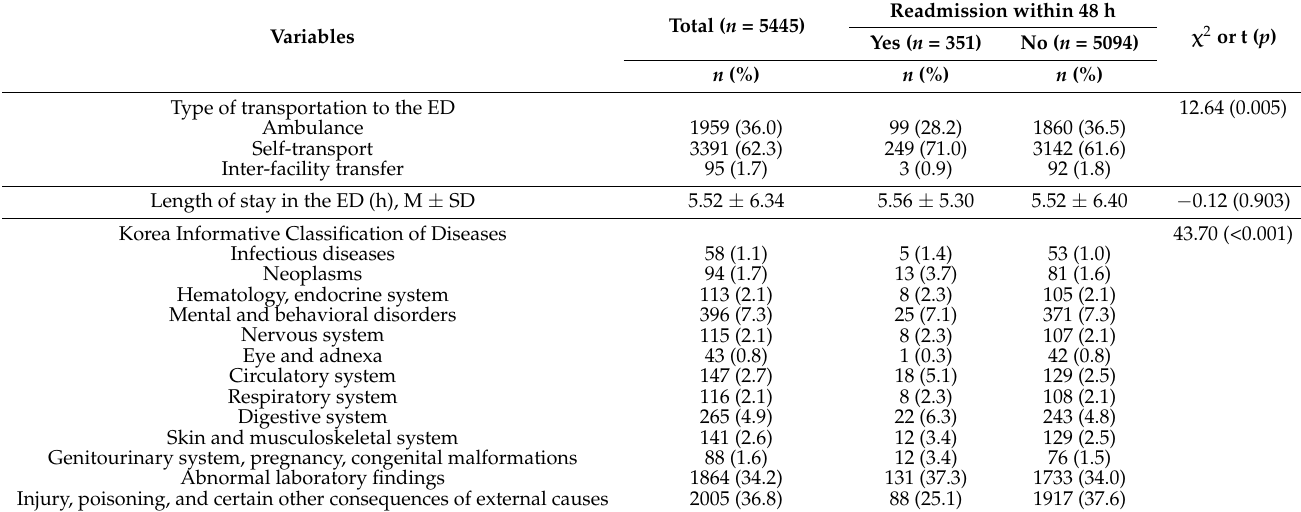
Table 2. Characteristics of emergency medical services stratified by readmission within 48 h.